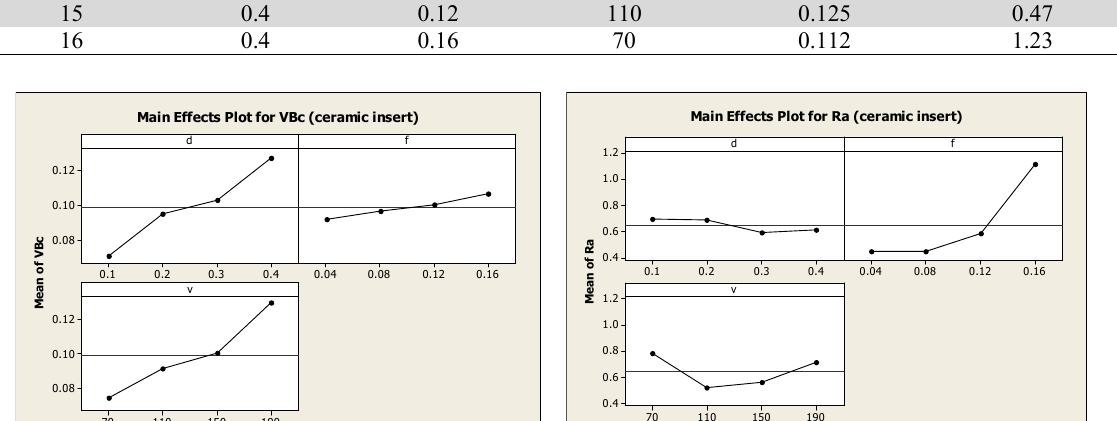
Main Effects Plot for VBc (ceramic insert) Main Effects Plot for Ra (ceramic insert)